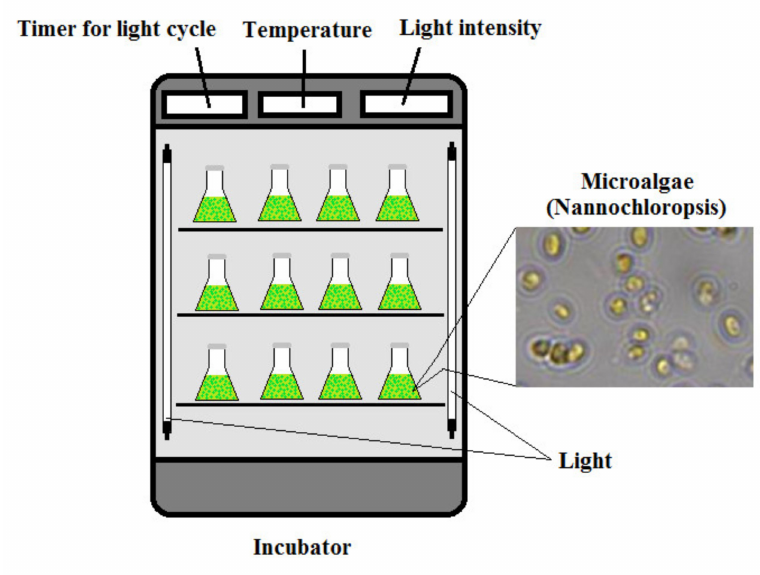
Figure 1. Experimental system used to culture microalgae in this